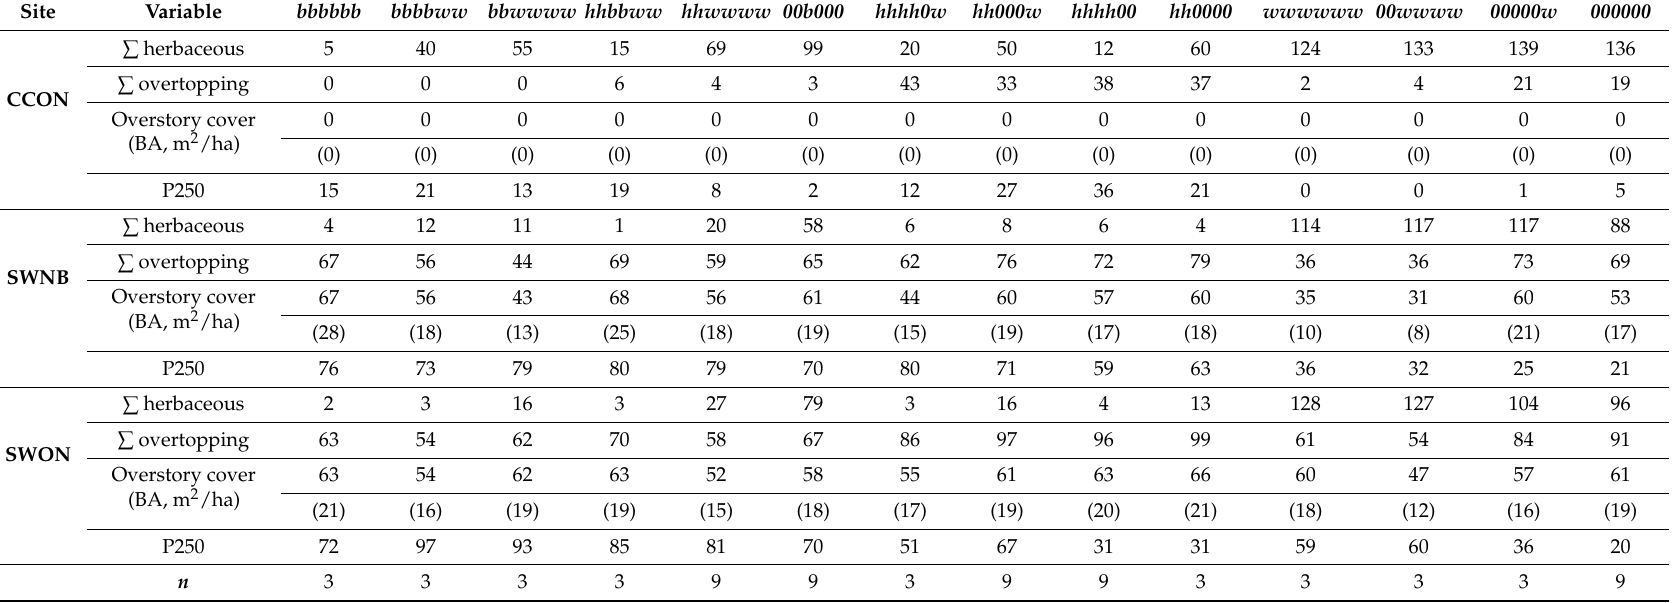
Table 3. Treatment mean non-crop cover values used to produce model (3) (Figure